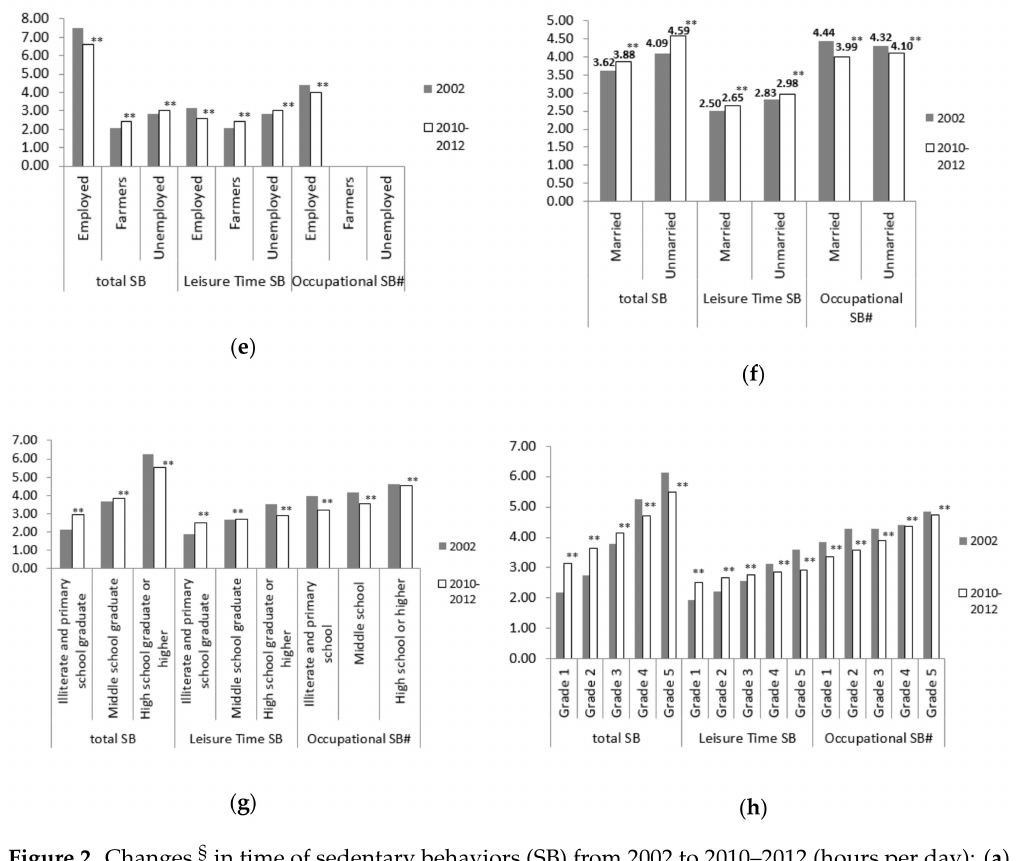
Figure 2. Changes § in time of sedentary behaviors (SB) from 2002 to 2010–2012 (hours per day): ( a ) changes in total participants; ( b ) changes by gender; ( c ) changes by age group; ( d ) changes by region; ( e ) changes by occupation; ( f ) changes by; ( g ) changes by educational level; ( h ) changes by family economic level ( § gender and age standardized to the 2010 China census population; # Time of Occupational SB was only calculated in employed participants, n 2002 = 12,625, n 2010–2012 = 31,914; ** p < 0.001, significance is based on